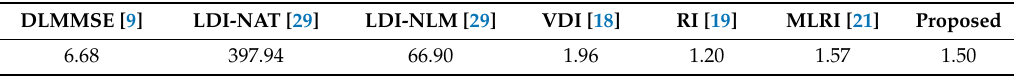
Table 4. Average computation time (s) on MCMaster